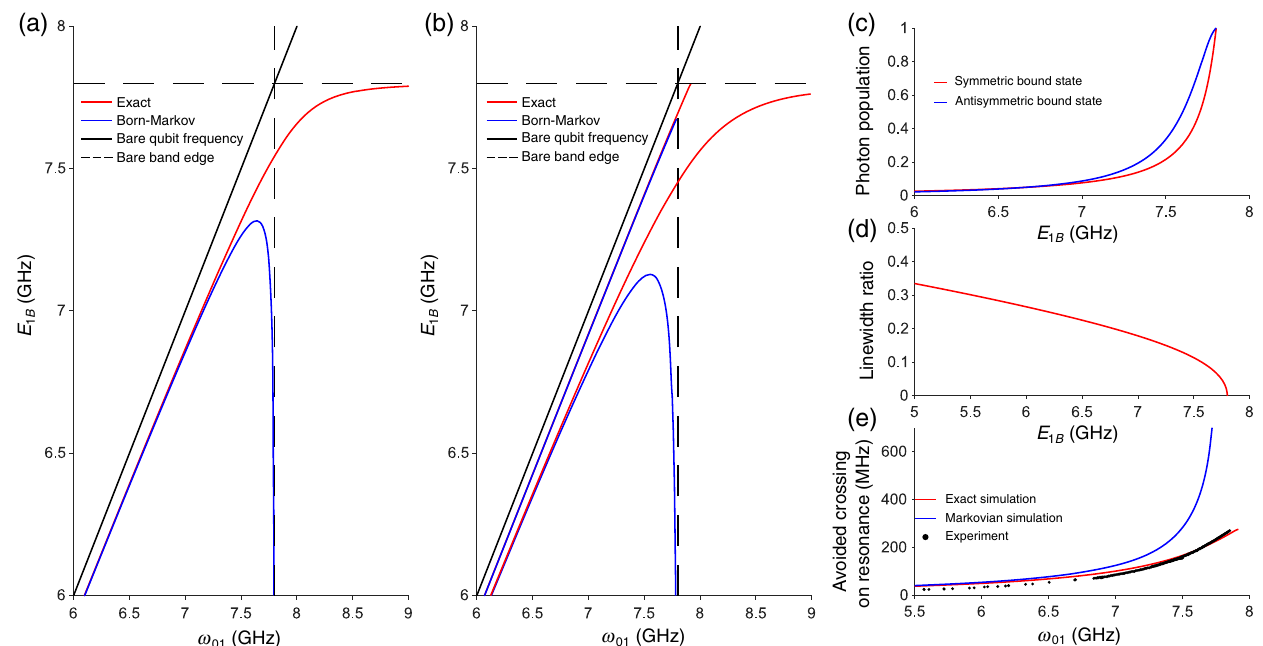
− z 1 . (c) Theoretical photon 1 2 j ¼